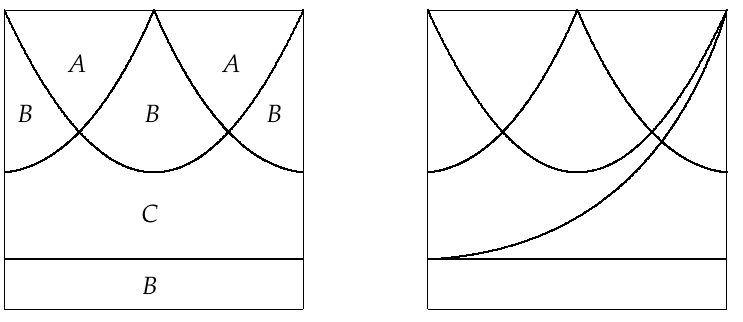
( φ , s ) < π φ , 0.4 < s < 1 . 4 { | | | }